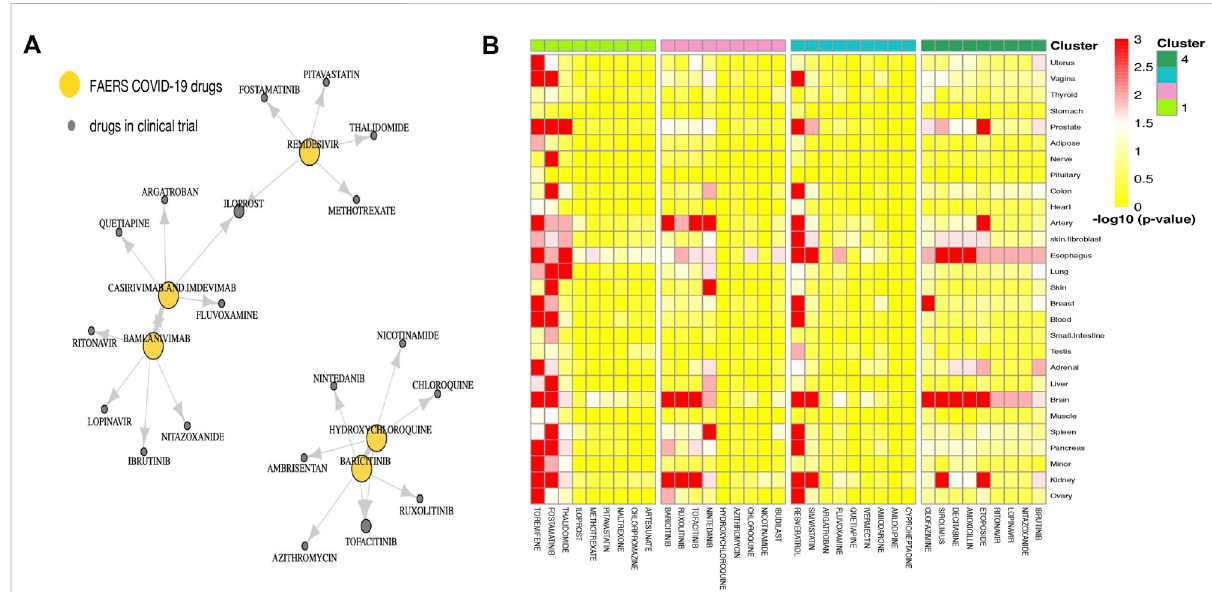
FIGURE 3 (A) Drug – drugsimilaritynetworkbetween fi vewidelyusedCEUAFDdrugsandtheir fi venearestneighbordrugs.ThearrowpointingfromdrugA